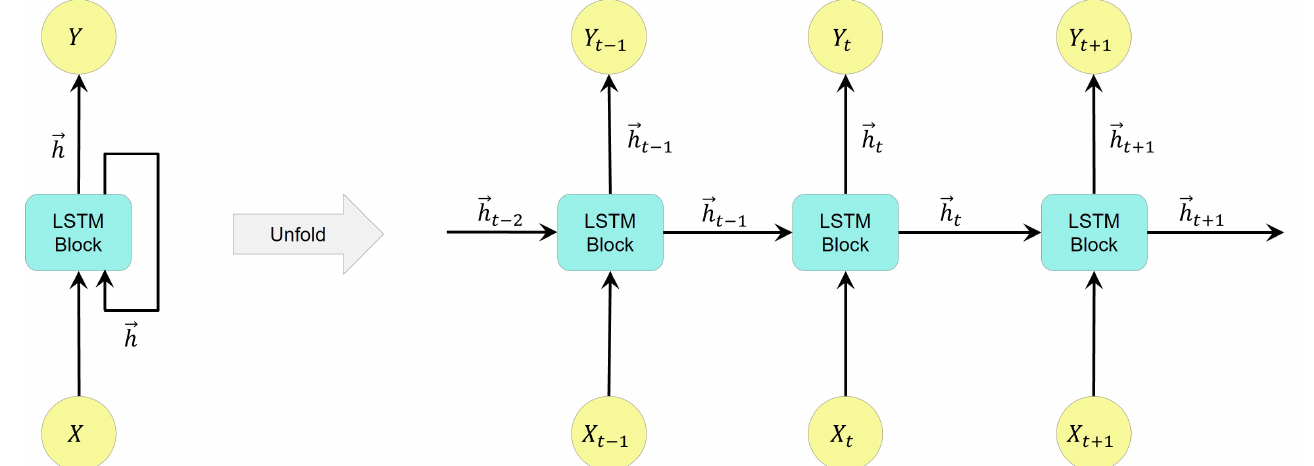
Figure 2. Flow of information in a unidirectional LSTM layer during different time steps with forward states, where X , Y , and (cid:126) h refer to the input, output, and forward states in the LSTM layer,